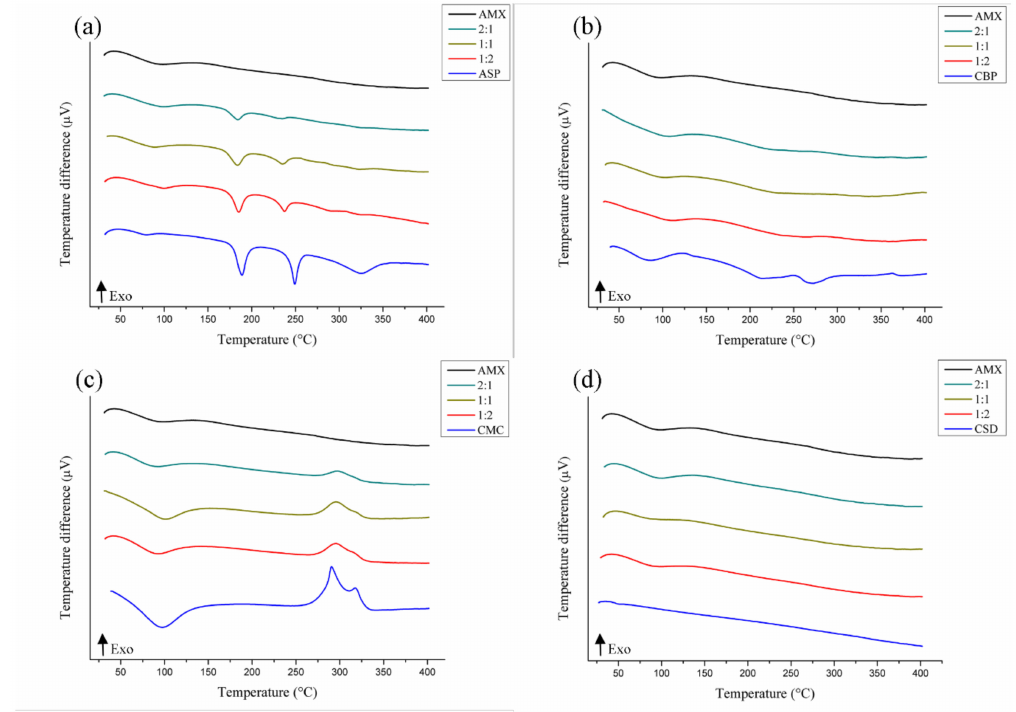
Figure 2. DTA curves of binary mixtures of AMX with pharmaceutical excipients: aspartame ( a ), carbopol ( b ), carboxymethylcellulose ( c ), and colloidal silicon dioxide ( d